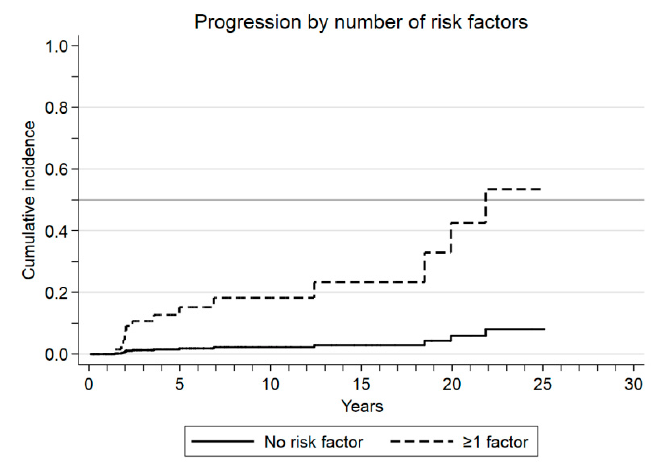
Figure 3. Cumulative incidence of progression in the framework of death as a competing event according to the number of risk factors at the diagnosis of asymptomatic IgM monoclonal gammopathy (immunoparesis and bone marrow lymphoplasmacytosis ≥ 20%).